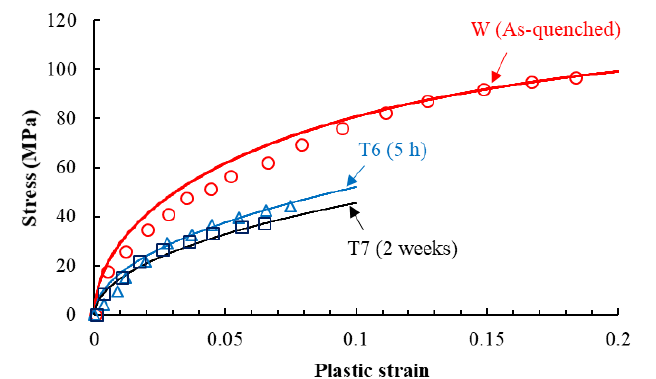
Figure 4. Comparison of the work hardening behaviour of AA6063 with different artificially aged states (time) at 185 °C from experiments (symbols [33]) and modelling results from Table 1 (lines).